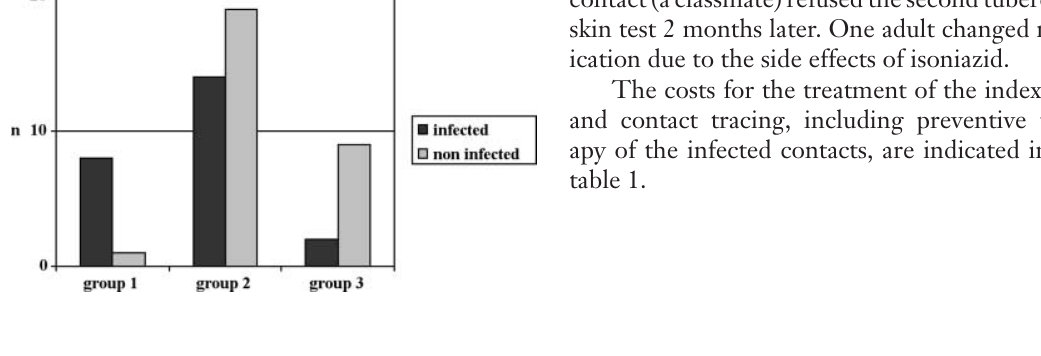
Cost estimation of treatment of the index case and contact tracing (all figures are given in